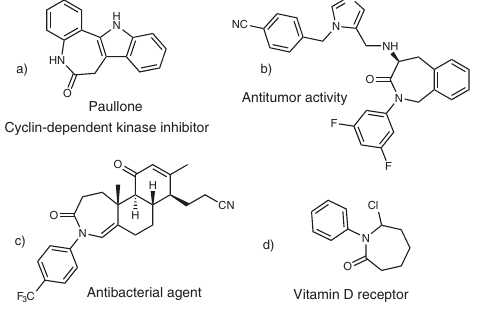
Fig. 1 | Biologically important azepinone derivatives. a Azepinone-based cyclin- dependent kinase inhibitor. b Azepinone-based antitumor compound. c Azepinone-based antibacterial agent. d Azepinone-based vitamin D